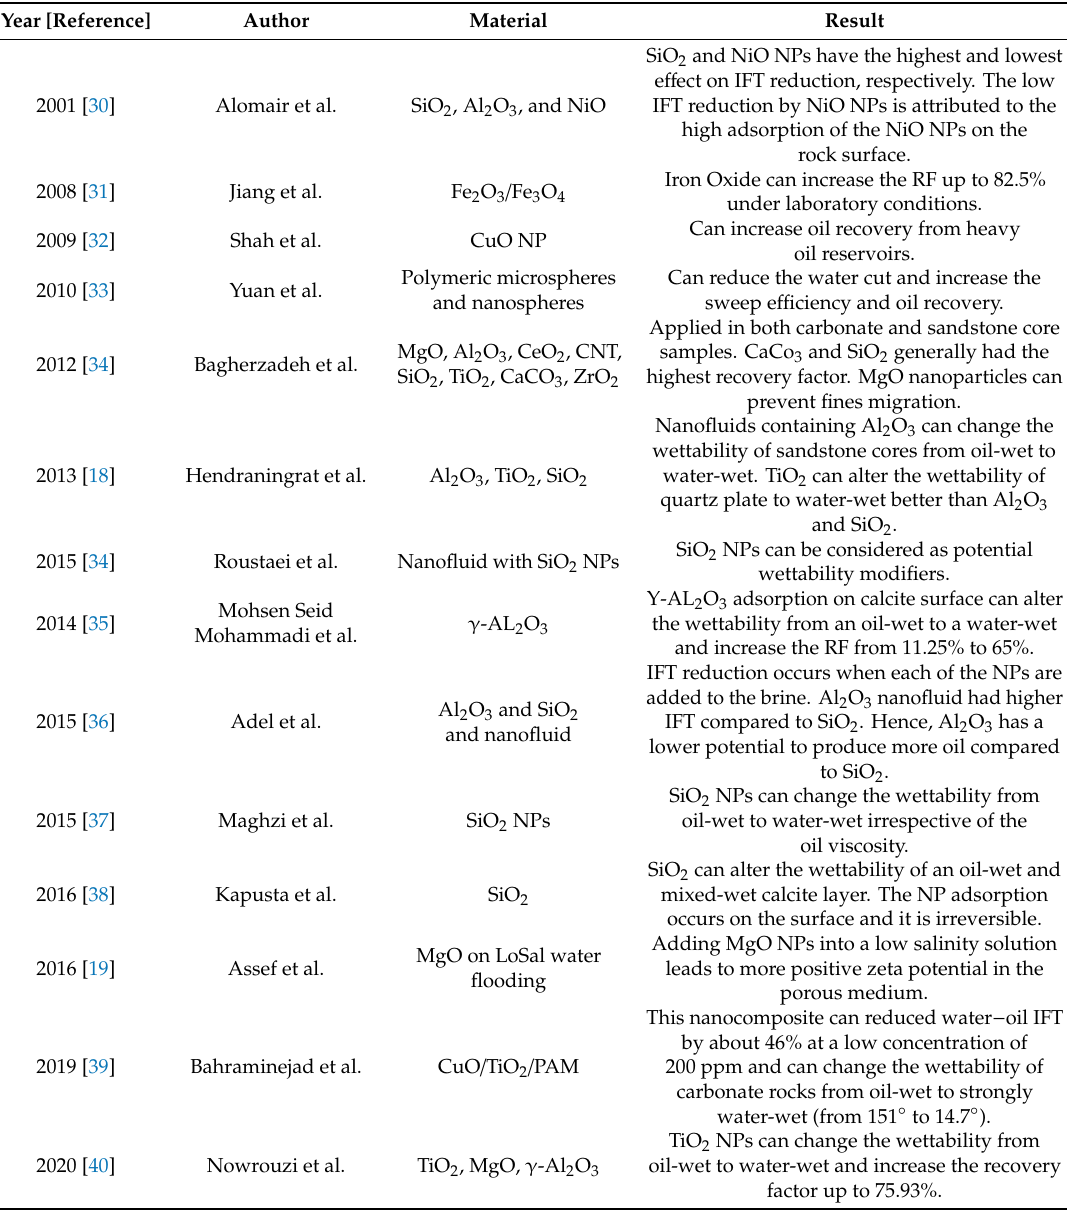
Table 1. A summary review of some previous studies reported on application of nanoparticle in EOR